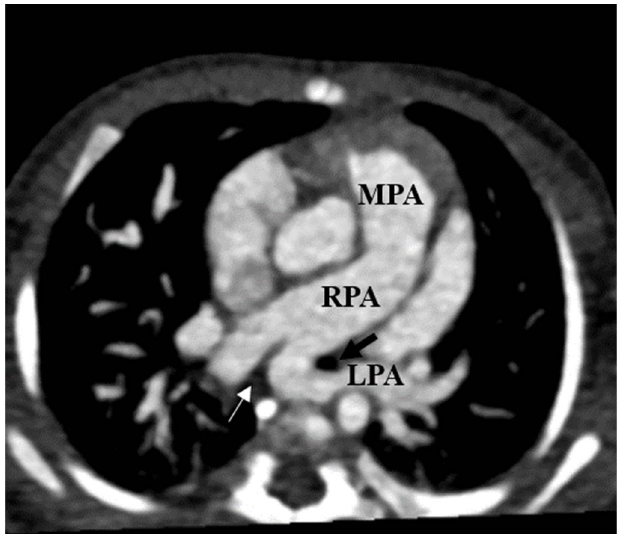
Figure 4. Incidental finding of PALPA in a 51-year-old male with acute shortness of breath. Contrast enhanced chest CT obtained to rule out pulmonary embolism demonstrates that a duplicated left pulmonary artery with a small left pulmonary artery (thin arrow) to left upper lobe was arising from the main pulmonary artery (bold arrow) and an additional anomalous left pulmonary artery to the left lower lobe (notched arrow) was arising from the proximal posterior part of the right pulmonary artery (curved arrow) on axial oblique reconstructed Maximum Intensity Projection (MIP) image ( A ) and Volume Rendered reconstructed image ( B ). There was no associated congenital heart disease or tracheobronchial stenosis. Coronal Minimum intensity projection (MinIP) ( C ) reconstructed image from same patient shows that the course of anomalous LPA branch (PALPA, bold black arrow) is caudal to the carina and is inferior anterior and parallel to the left main bronchus (LMB). There was no tracheal (T), right main (RMB) or left main bronchial (LMB), or esophageal compression. Note that left upper lobe and the lingula were supplied by the proximal left pulmonary artery (thin black arrow) which arises in the usual position from the main pulmonary artery (MPA). Note peripheral reticular opacities and ground glass opacities in both lungs related to known non-specific interstitial pneumonia (NSIP).